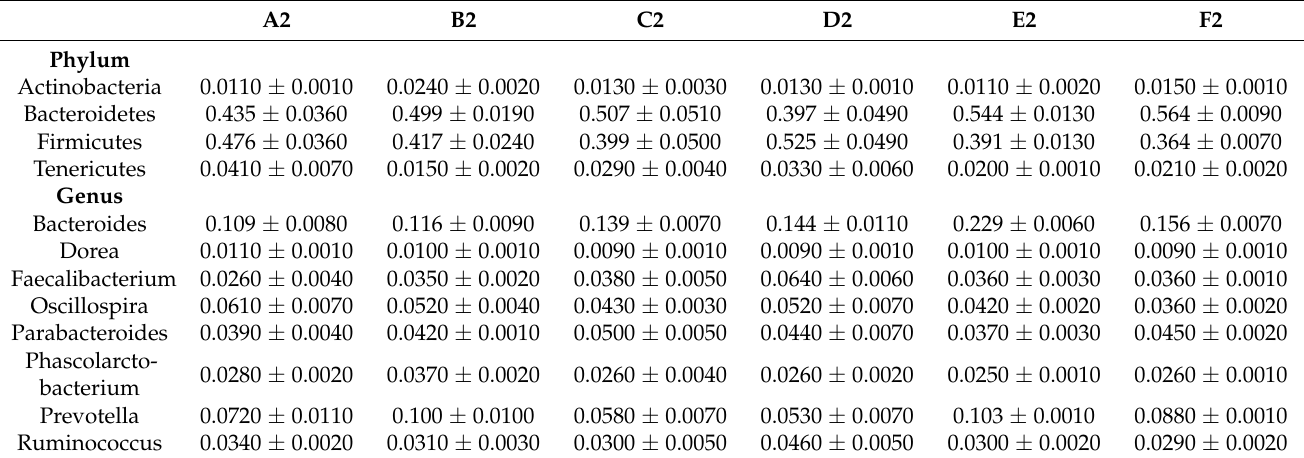
Table 7. The relative abundance of dominant bacteria from different groups on day